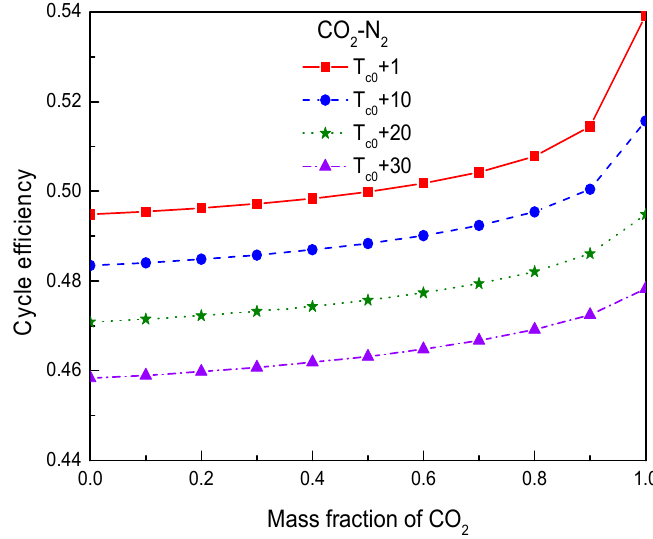
Figure 19. Cycle efficiency of CO 2 -N 2 at different compressor inlet temperatures.